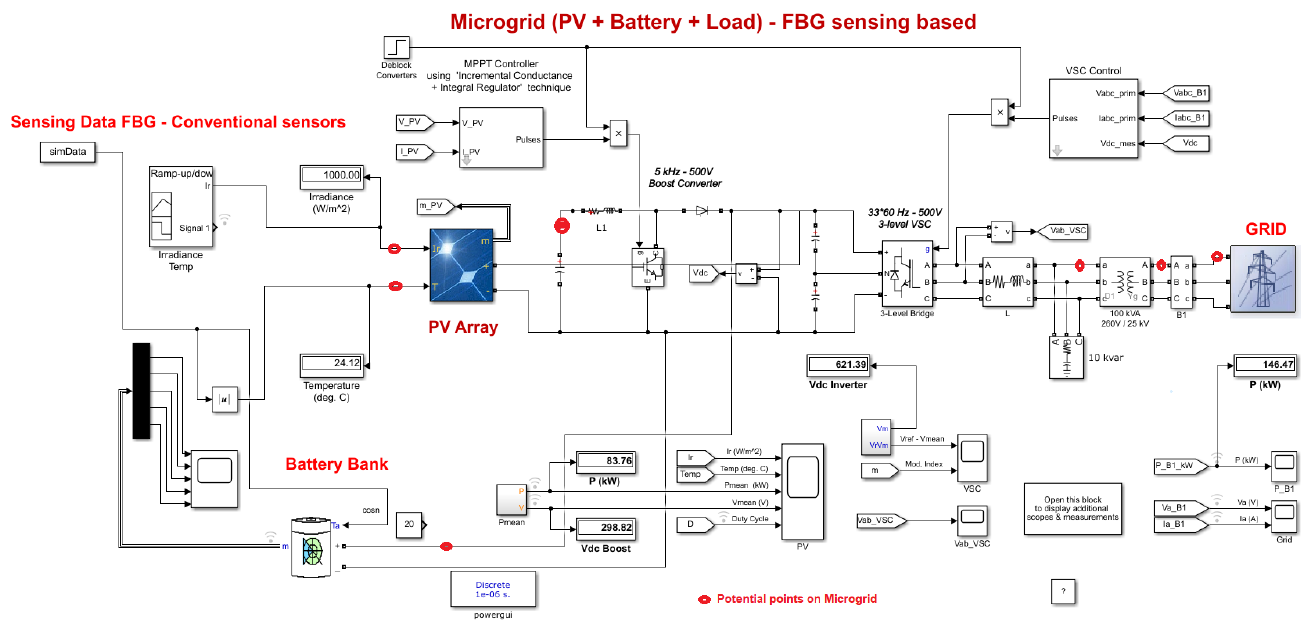
Figure 3. Simulink model of MG.